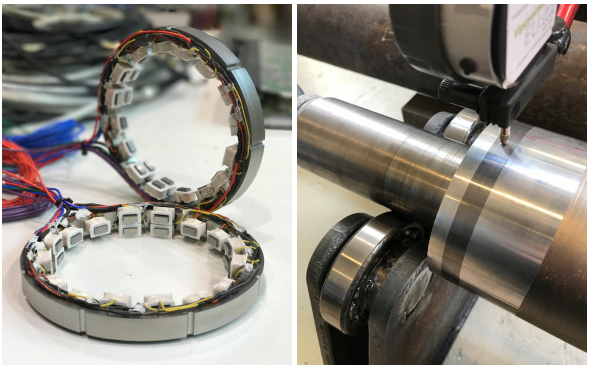
Figure 6. Inductive differential three-axis rotor displacement sensor. Laminated stator stacks with windings ( left ) and laminated rotor sensing surface with non-magnetic aluminium surroundings installed on electrical machine rotor ( right ).